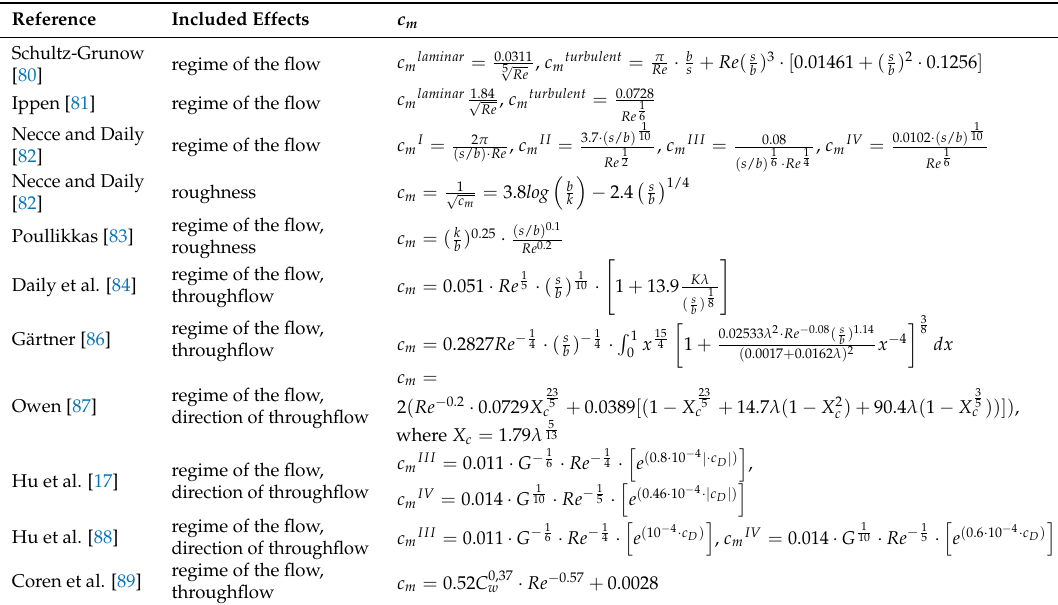
Table 1. Overview of equations for estimation of moment